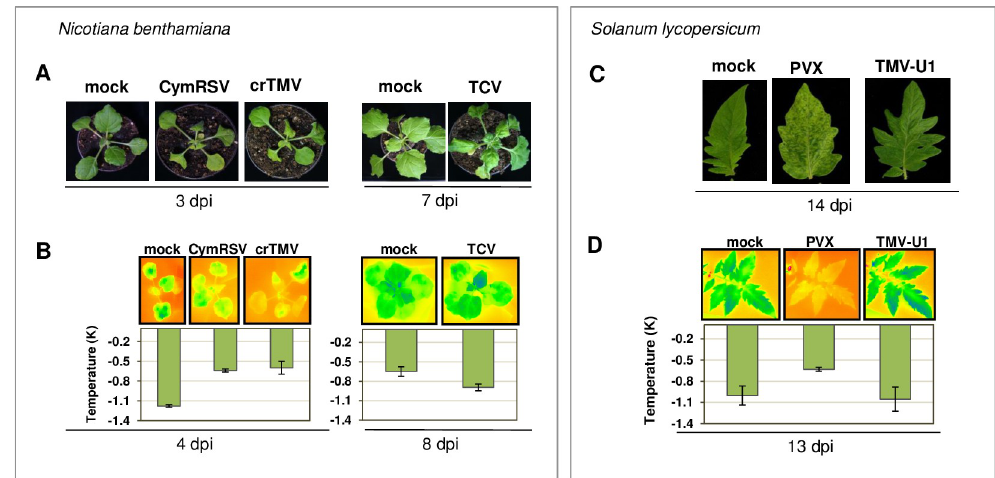
Fig 7. Symptoms and temperature changes in virus-infected N . benthamiana and S . lycopersicum plants. Photos in visible light (A) and thermographic images (B) of mock-inoculated and virus-infected N . benthamiana (A, B) and S . lycopersicum plants (C, D). Thermographic images show the difference between the ambient temperature and the leaf temperature of the virus-infected and control plant as a colour image and as a column diagram (in Kelvin, K).